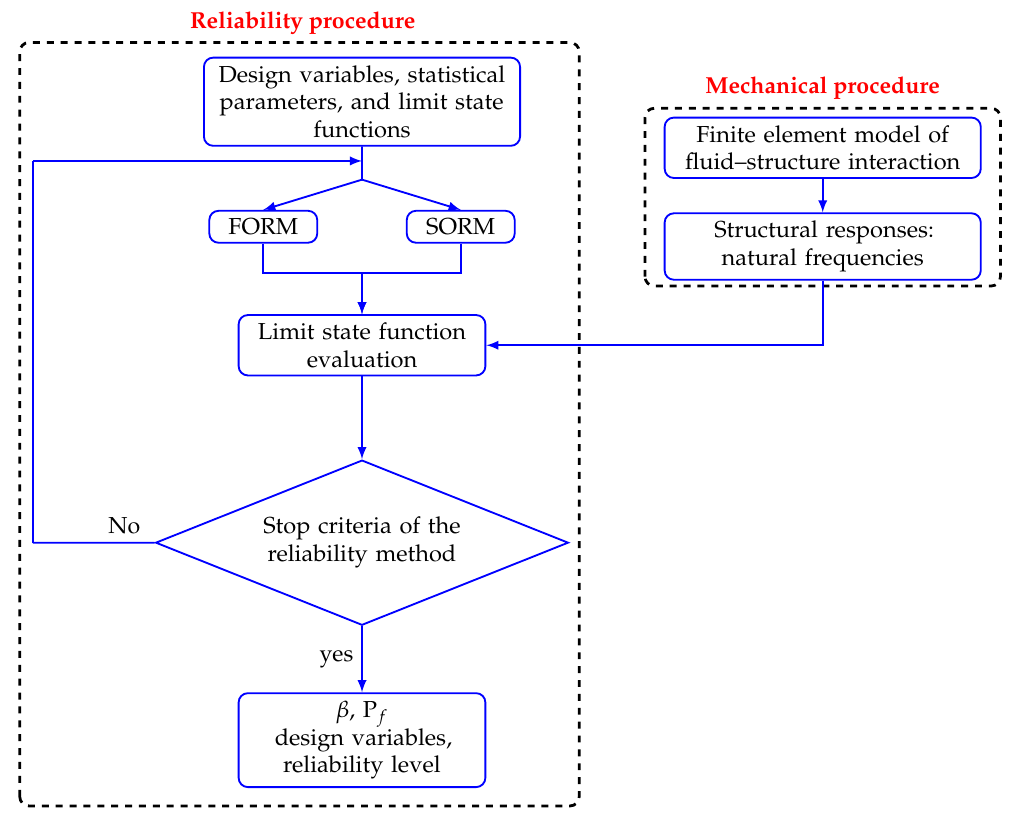
Figure 10. Reliability analysis methodology.